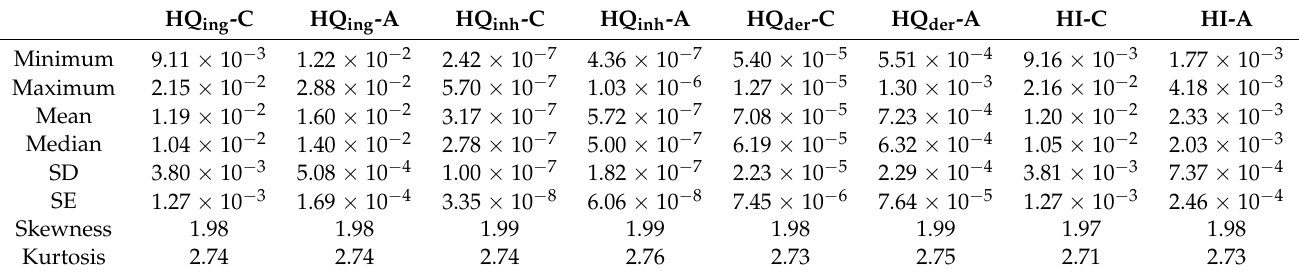
Table 4. Overall values of hazard quotient (HQ), and hazard index (HI), in the three exposure routes of Ni for children (C) and adults (A) in Klang River estuary and a site in Juru estuary. N = 9. HQ ing -C HQ inh -C